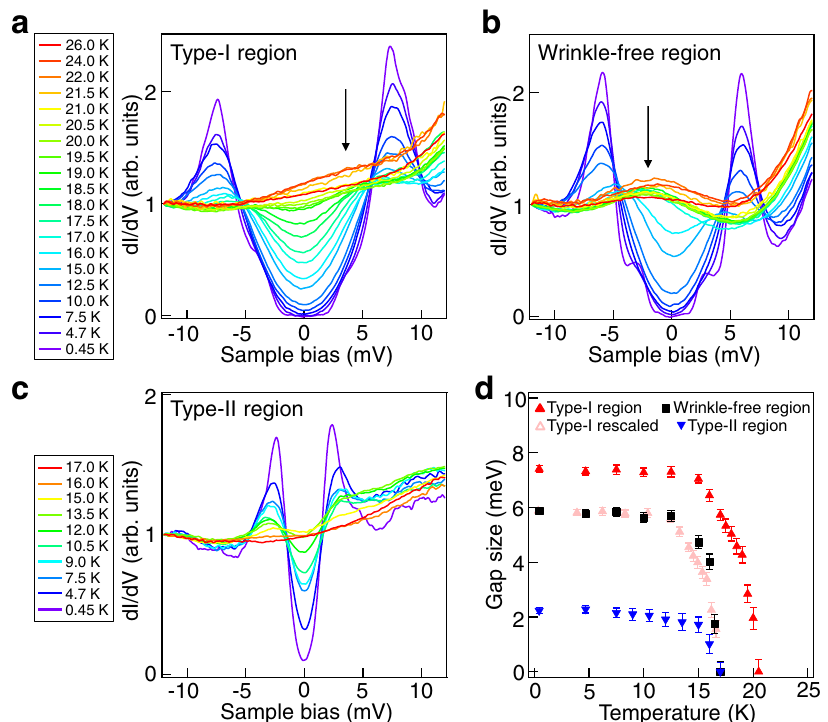
Fig. 3 Temperature dependence of superconducting gaps on the wrinkles. a – c Temperature-dependent d I /d V spectra taken at type-I wrinkle region, wrinkle-free region and type-II wrinkle region, respectively. The black arrows highlight the bump features of the LDOS. ( a ) and ( b ) share the same legend. Setpoint: V s = − 10 mV, I t = − 200 pA. d A plot of the gap sizes as a function of temperature extracted from a – c